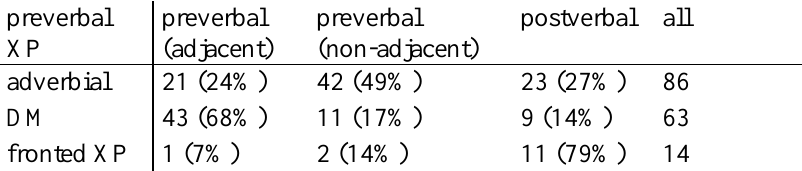
Table 3. Type of preverbal material and position of